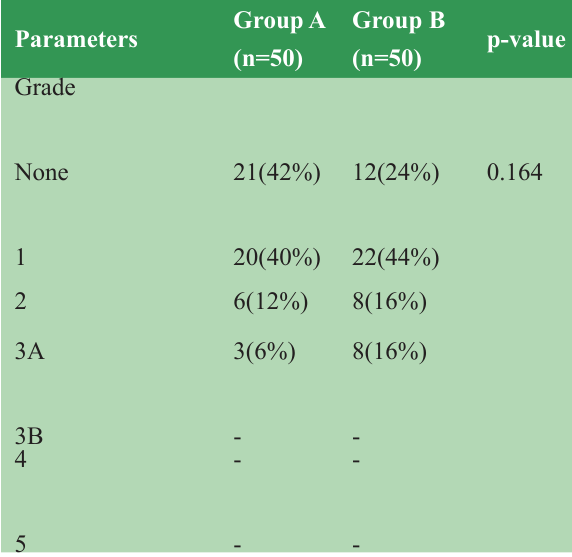
Table 4. Complications as per Modified Clavien